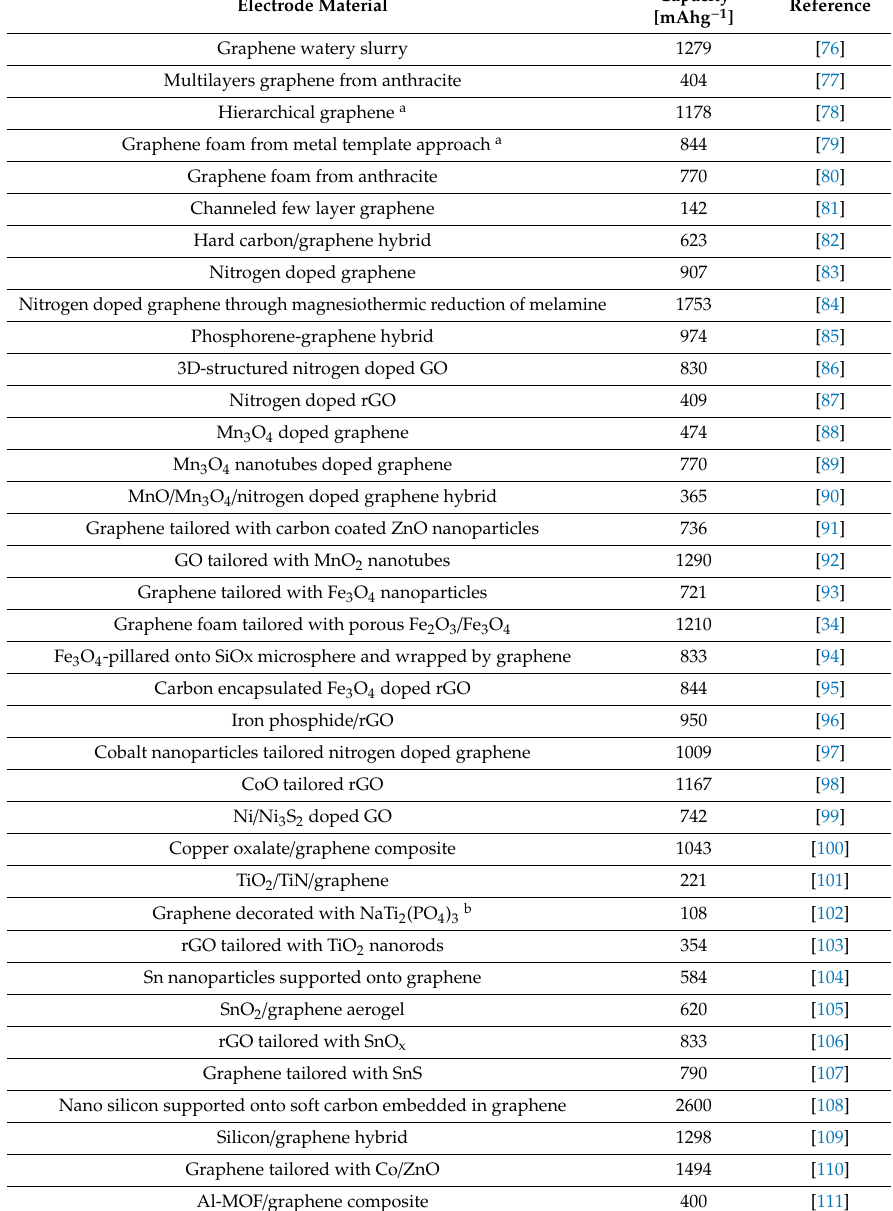
Table 1. Overview of the most representative anodes of lithium-based batteries based on graphene reported in the literature so